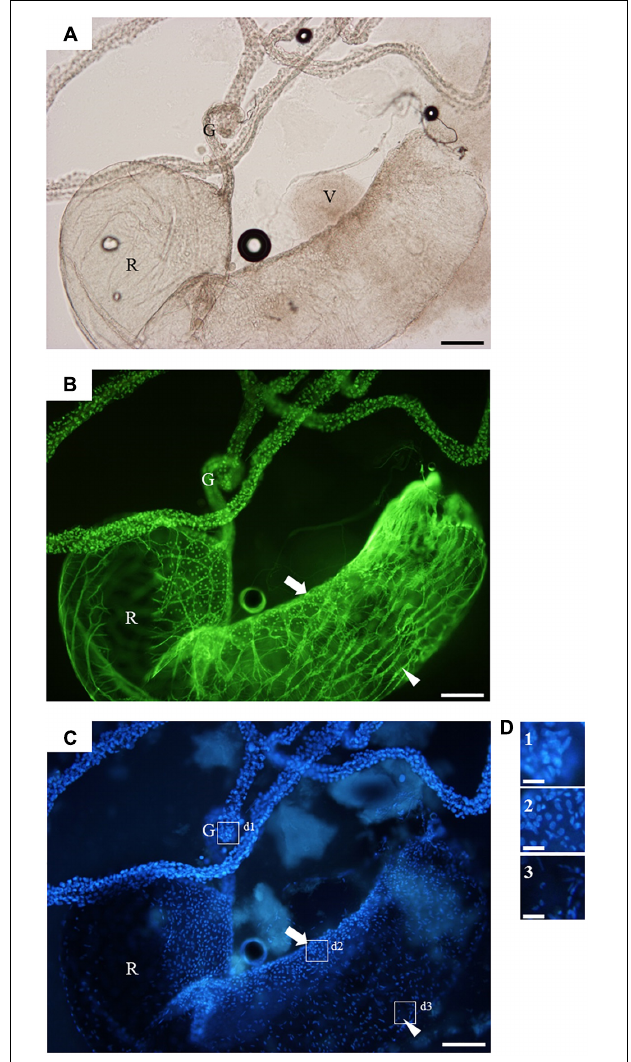
FIGURE 2 | The venom apparatus of B. pallida observed in fluorescence microscopy. (A) light microscopy, (B) FITC-conjugated phalloidin staining for actin detection, (C) DAPI staining for detection of nucleic acids, and (D) detailed view of (C) . G, venom gland; R, venom reservoir; V, venom; arrow, secondary secretory zone; arrowhead, muscular fiber; boxes d1, d2, and d3 refer to detailed views shown in panel (D) . Note the high density of the venom leaking from the ruptured reservoir in panel (A) , and the different shapes of nuclei that allow to discriminate between the different tissues composing the organ. Scale bars = 0,3 mm for (A) , (B) , and (C) or 50 µ m for (D) . and 462 bp) for D. rosae and B. pallida , respectively ( Table 1 and